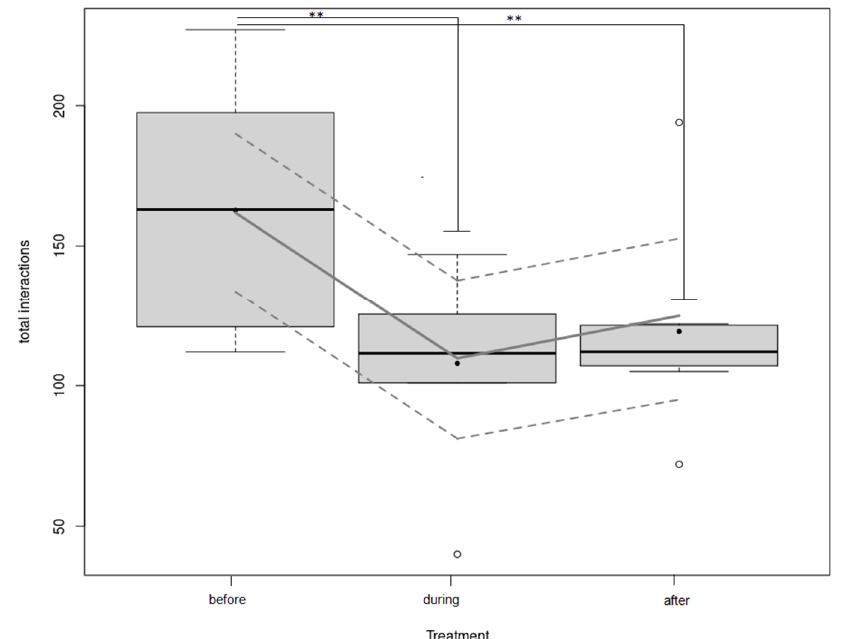
Figure 2. “Total interactions during Day1”. Boxplot of the total interactions recorded in the different treatments (before, during and after being housed in social box) during the first day. The horizontal line shows the median, the box extends from the lower to the upper quartile, and the whiskers to 1.5 × the interquartile range above the upper quartile or below the lower quartile. The black dots indicate the means. Significant differences between treatment are indicated as ** p ≤ 0.001. The lines show the model estimates (middle line) and 95% confidence intervals (upper and lower line).